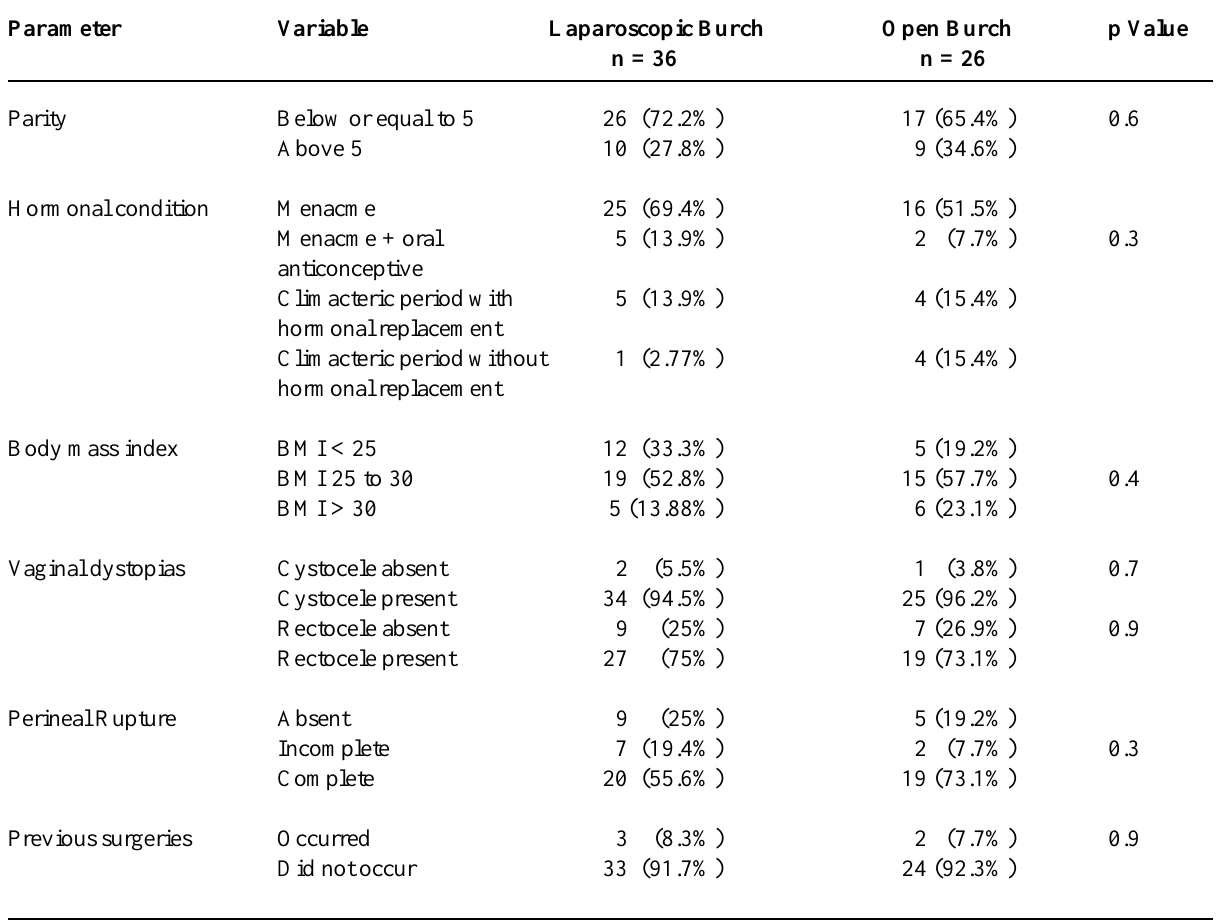
Table 1 – Assessment of parity, hormonal condition, body mass index, vaginal dystopias and previous surgical treatment of patients studied.